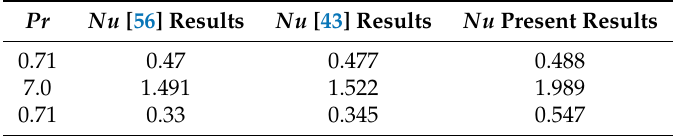
Table 9. Influence of Prandtl number Pr on Nusselt number Nu at ϕ = 0.